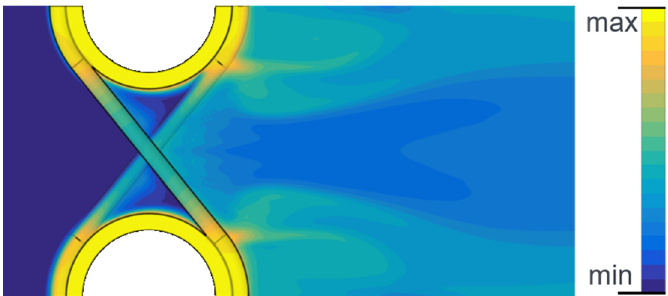
Figure 4. Exemplary temperature field within the gas-phase of a symmetric / periodic wire mesh heat exchangersection,asobtainedfromCFDanalysis. Theinnertubesurfacetemperatureissetto T c = 333.15 K. The inflow gas velocity and temperature are set to v g = 5.0 m/s and T g , in = 293.15 K, respectively.